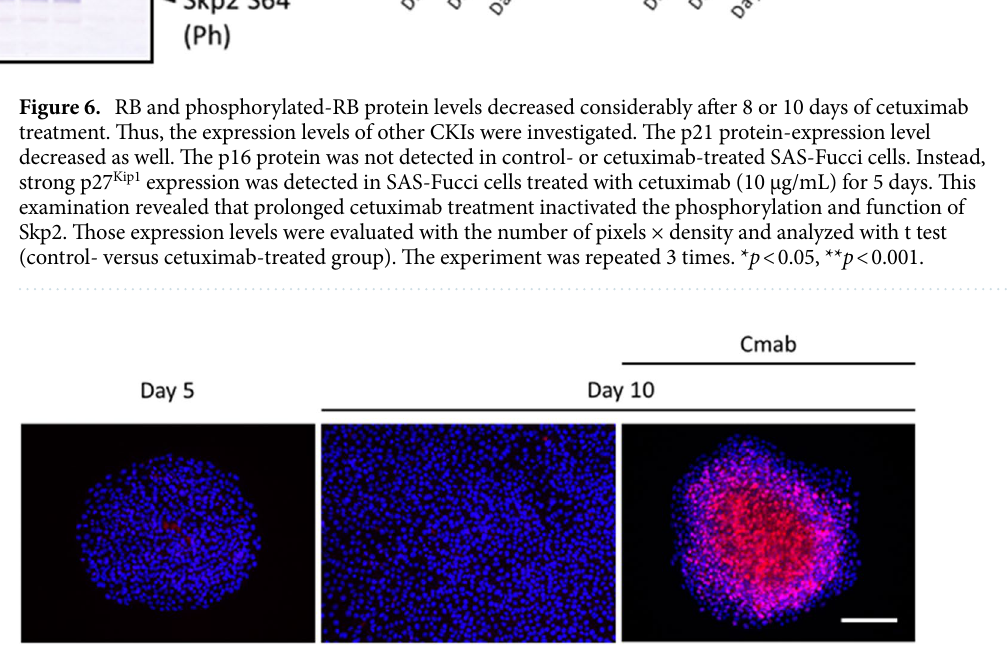
Figure 7. Immunofluorescent staining also confirmed that p27 Kip1 was highly expressed in the central regions of colonies that formed after treatment with cetuximab (10 µg/mL) for 10 days, which was not observed in control cells following a 10-day treatment. This expression was not also detected in the same sized colonies which were established with 5-day incubation. Scale bar: 500